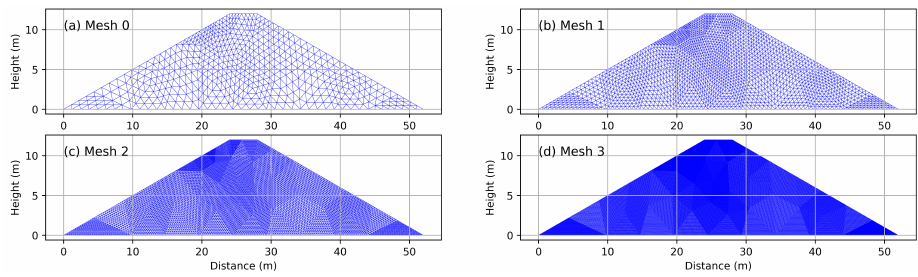
Figure 2. Grids with ( a ) 992 triangles, ( b ) 3968 triangles, ( c ) 15,872 triangles, ( d ) 63,488